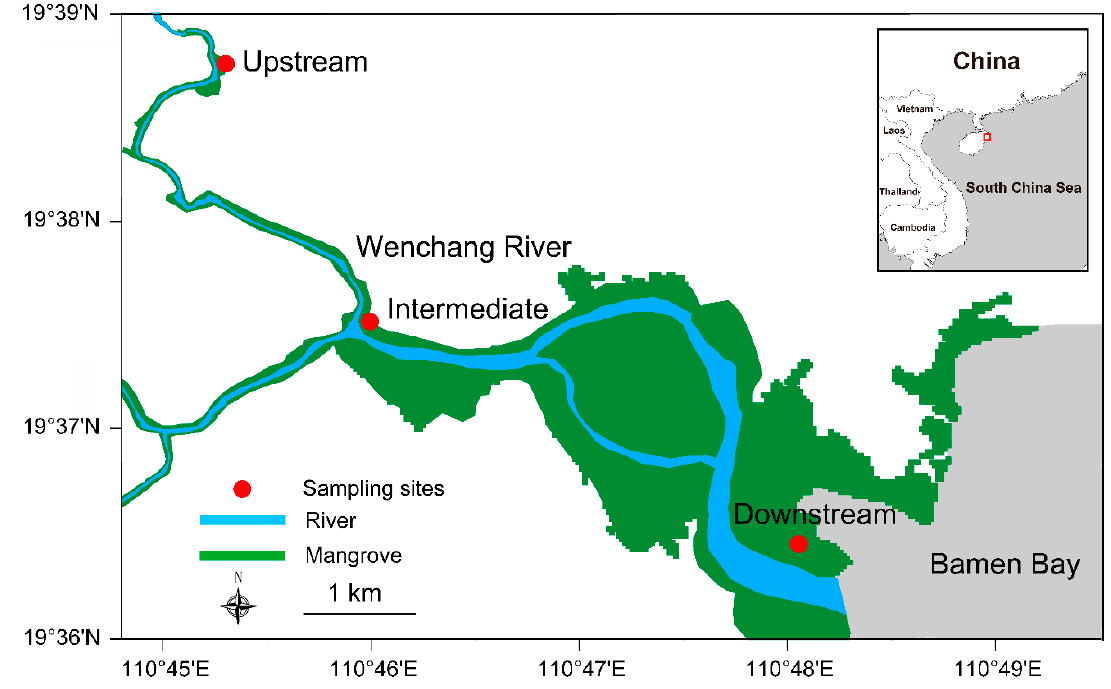
Figure 1. Map of the study area (Bamen Bay, Hainan, China) showing the mangrove distribution and the locations of sites surveyed.